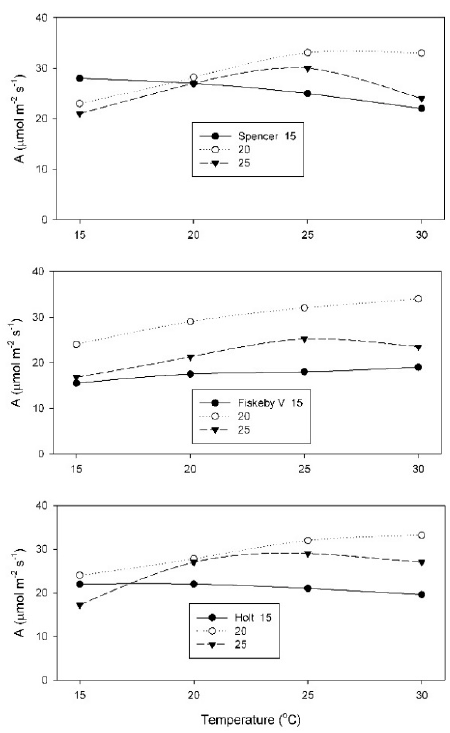
Figure 1. Values of the net rate of CO 2 assimilation (A) measured at 400 µ mol mol − 1 external CO 2 over a range of leaf temperatures, for plants of three cultivars, grown at 15, 20, or 25 °C. Each point represents a mean for 3 or 4 leaves.